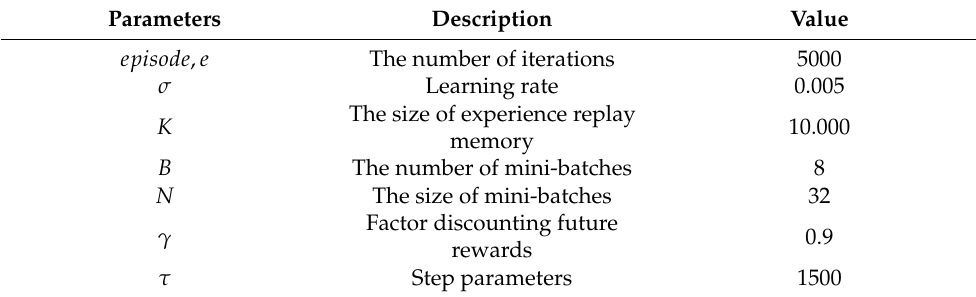
Table 4. The hyperparameters for DQN